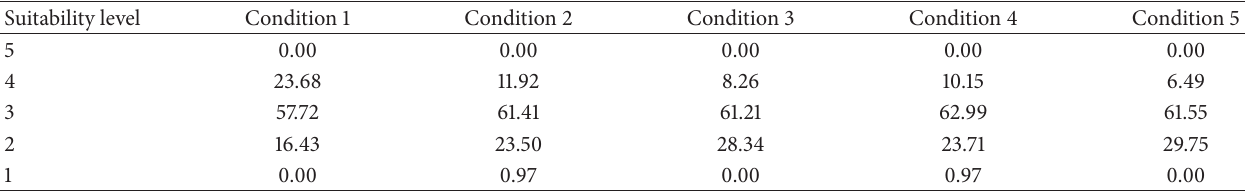
Table5:Thesuitabilitylevelsforwaterharvestingofthetotalbasinarea(inpercent)accordingtodifferentweightcombinationsofinfluencing variables: suitability levels 1-2: low suitability, suitability level 3: moderate suitability, and suitability levels 4-5: high